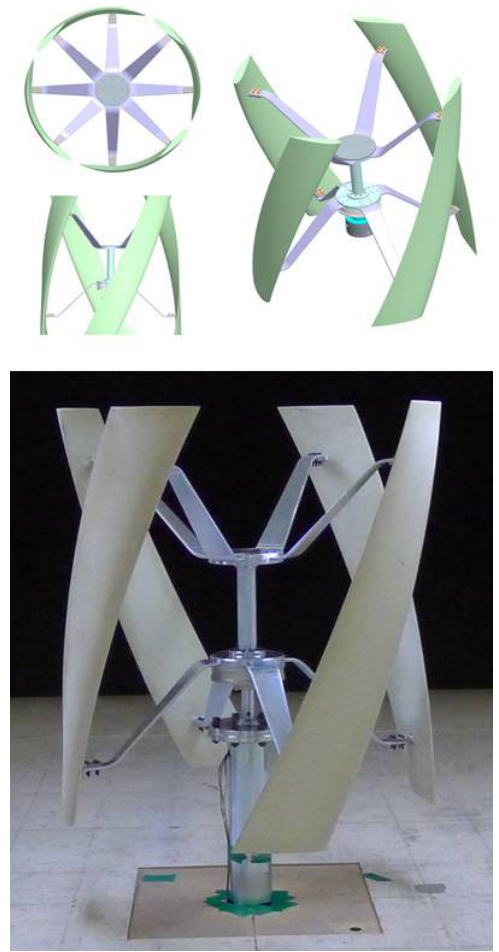
Figure 6. 100-W helical-blade vertical-axis wind turbine.